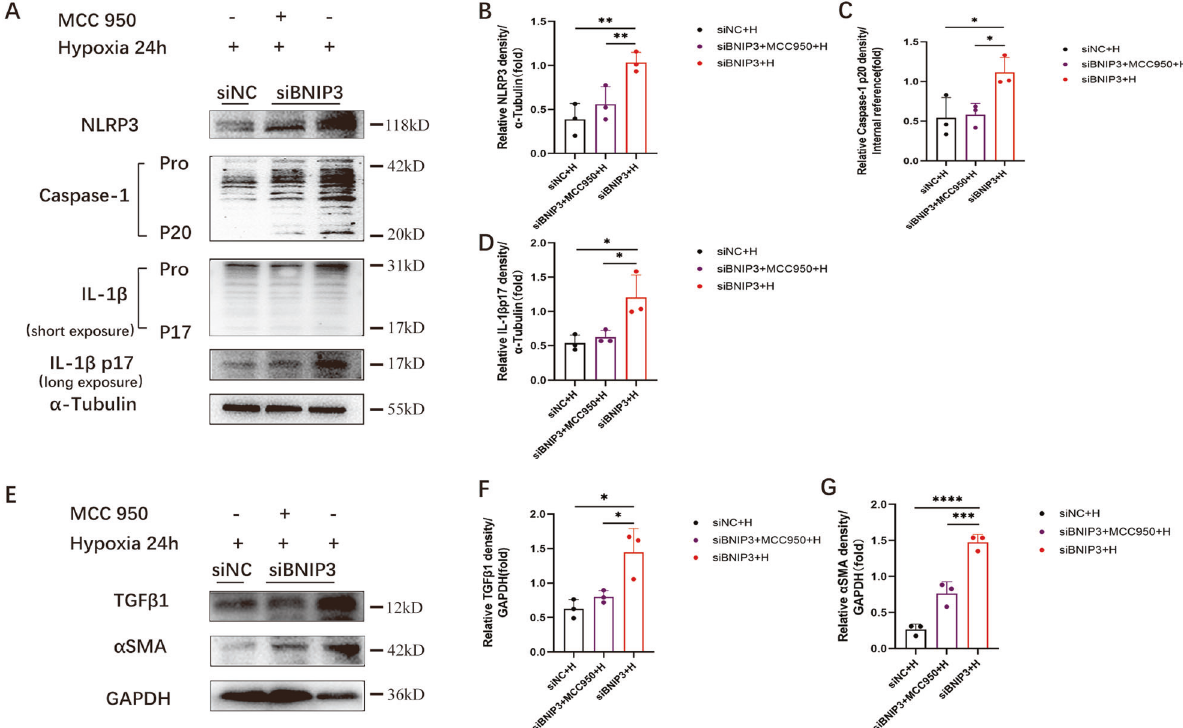
Fig. 7 NLRP3 in fl ammasome inhibition alleviated hypoxia-induced fi brosis in HK-2 cells after silencing BNIP3. After transfected by siNC or siBNIP3 for 6 h, HK-2 cells were pretreated with MCC950 (10 μ M) for 4 h and then cultured under the hypoxic conditions for 24 h. A Immunoblot analysis of protein levels and B – D quanti fi cation of NLRP3, caspase-1 p20, IL-1 β p17 in HK-2 cells ( n = 3 per group). E Immunoblot analysis of protein levels and F , G quanti fi cation of α SMA and TGF β 1 in HK-2 cells ( n = 3 per group). Error bars: SEM. * p < 0.05; ** p < 0.01; *** p < 0.001; **** p <